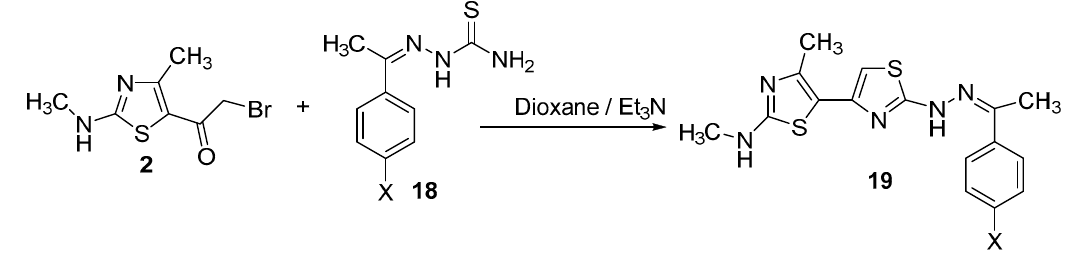
Scheme 5. Synthesis of compounds 19a –